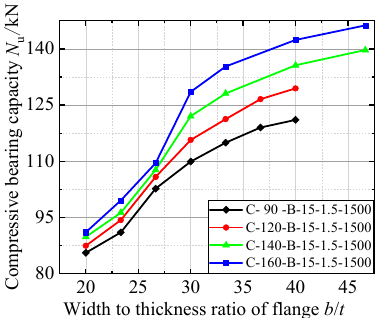
Figure 15. F - Δ relationship curves of C90- B -15-1.5-1500.